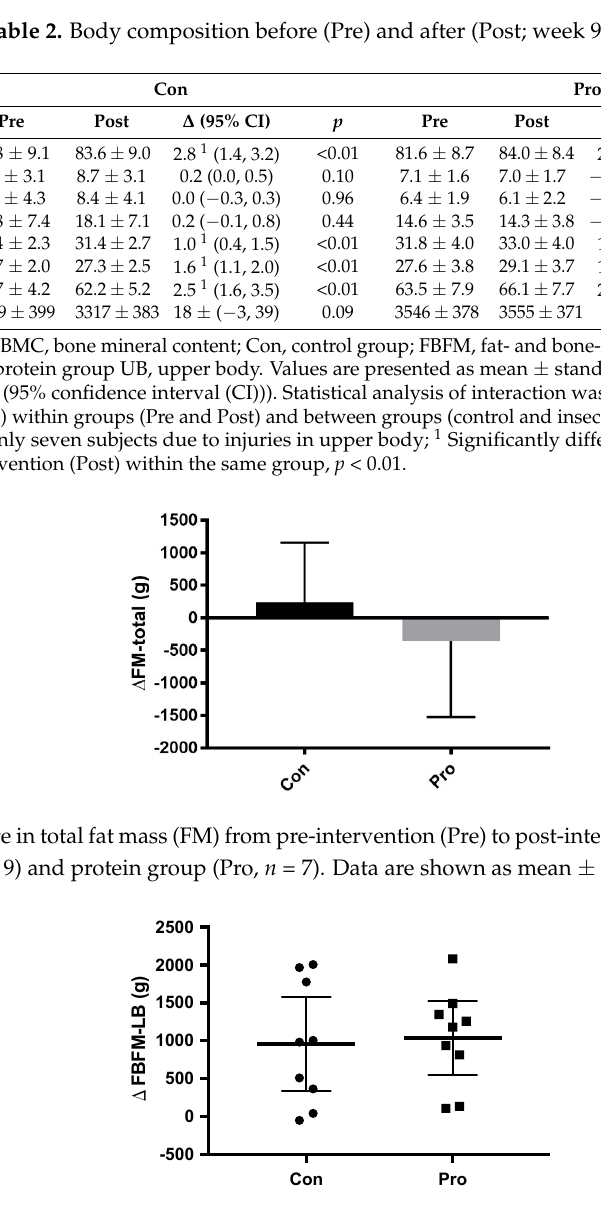
standard deviation (SD), with all delta values as ( Δ (95% confidence interval (CI))). Statistical analysis of interaction was by 2 × 3 ‐ factor analysis of variance (ANOVA) within groups (Pre and Post) and between groups (control and insect protein); * Data for protein group included only seven subjects due to injuries in upper body; 1 Significantly different from pre ‐ intervention (Pre) to post ‐ intervention (Post) within the same group, p < 0.01.